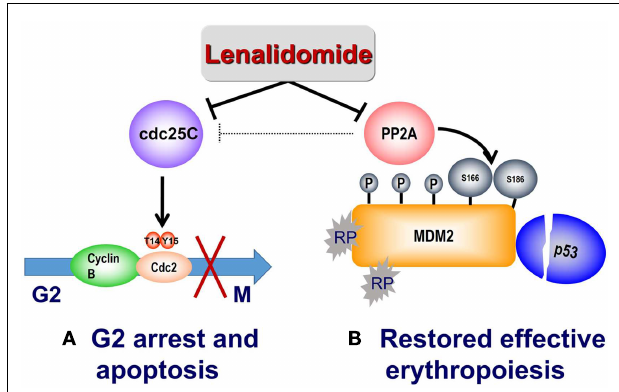
FIGURE 2 | Mechanism of action of lenalidomide in del(5q) MDS . (A) Lenalidomide directly inhibits Cdc25C, resulting in G2/M arrest and apoptosis in del(5q) cells. Lenalidomide also indirectly inhibits PP2A with consequent Cdc25C inactivation. (B) Reduced expression of RPS14 results in binding of free ribosomal proteins (RP) to MDM2, thereby triggering its auto-ubiquitination and p53 accumulation. Lenalidomide inhibition of the phosphatase PP2A results in hyperphosphorylation of MDM2 at Ser 166 and Ser 186 and stabilization of MDM2, with consequent p53 degradation and restored cell-cycle